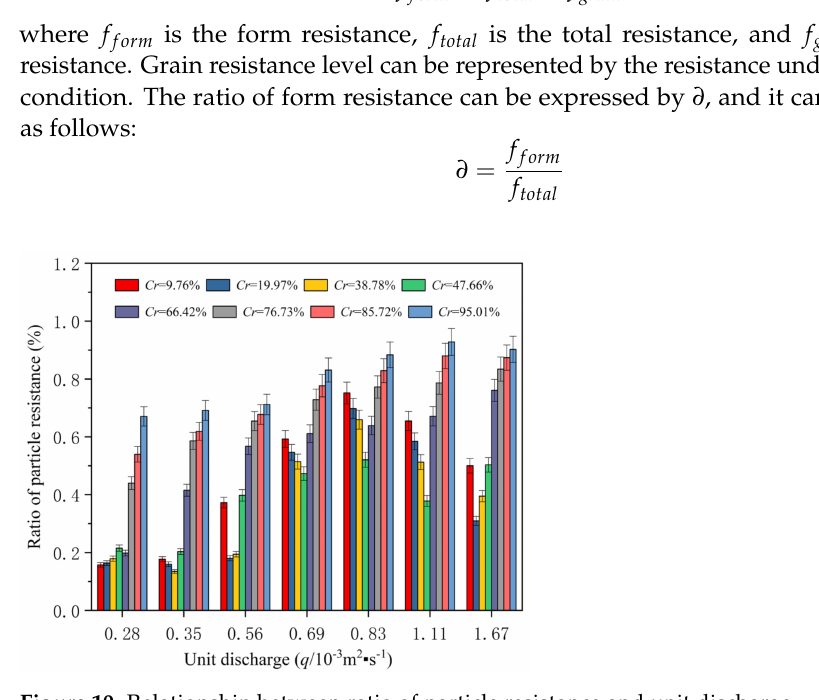
Figure 10. Relationship between ratio of particle resistance and unit discharge. When the degree of vegetation coverage is relatively low, the ratio of form resistance first increases and then decreases with the flow rate. The critical degree of coverage corresponding to the maximum form resistance is 66.42%. For example, when the degree of vegetation coverage is 9.76%, as the unit discharge increases from 0.00028 m 2 /s to 0.00083 m 2 /s, the ratio of form resistance increases from 0.176 to 0.521; however, as the flow rate continues to increase to 0.00167 m 2 /s, form resistance gradually drops to 0.309. When the degree of vegetation coverage is relatively high, the ratio of form resistance in the total water flow resistance increases with an increase in the flow rate, and the rate of increase gradually decreases with an increase in the density. For example, when the degree of vegetation coverage is 85.72%, as the unit discharge increases from 0.00028 to 0.00167 m 2 /s, the ratio of form resistance gradually increases from 0.663 to 0.874, which shows an increase of 0.211. However, when the degree of coverage is 95.01%, within the same range of flow rate, the ratio of form resistance increases from 0.758 to 0.903, which represents an increase of only